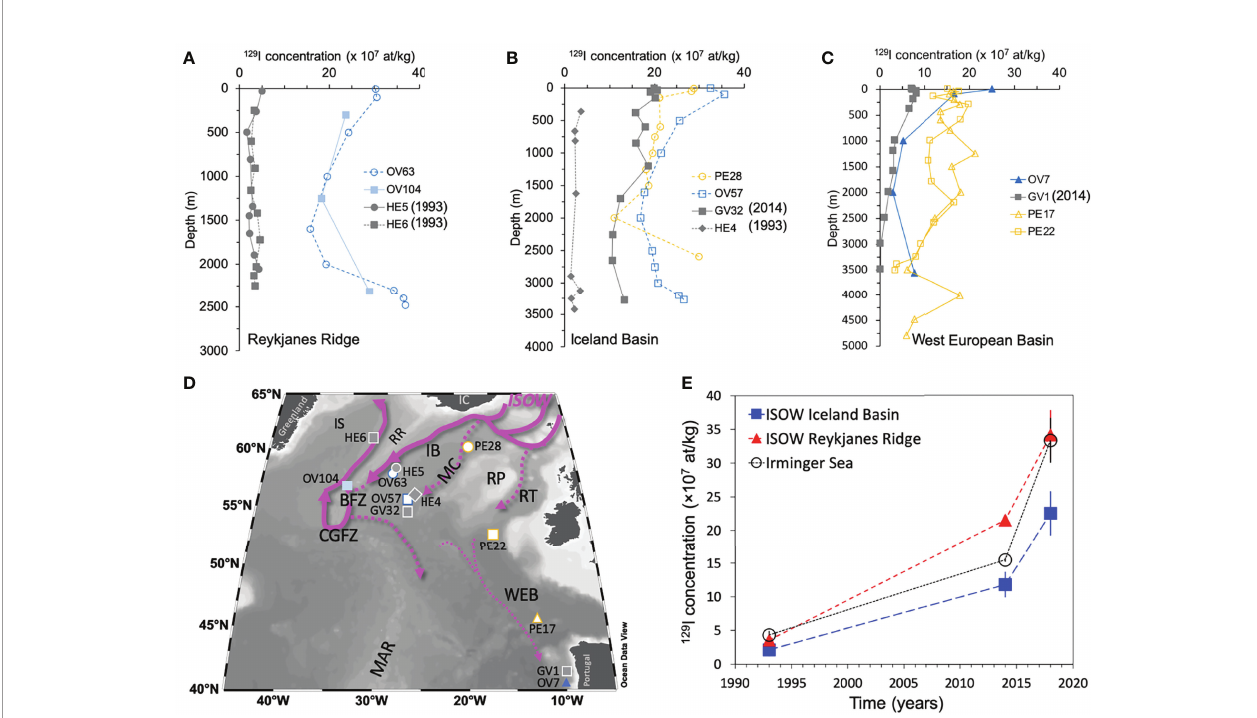
FIGURE 4 | 129 I in the Northeastern Atlantic Ocean. Depth pro fi les of 129 I obtained during OVIDE cruise in 2018 (OV, blue) and the PE424 cruise in 2017 (PE, yellow) at (A) Reykjanes Ridge, (B) the Iceland Basin, and (C) the West European Basin, are represented and compared to nearby depth pro fi les available in the literature (grey pro fi les): HE sites measured in 1993 by Edmonds et al. (2001) and GV sites from the GEOVIDE cruise in 2014 (Castrillejo et al., 2018) revisited during OVIDE in 2018. (D) Map showing the stations (*) and boundary (solid lines) and interior pathways of ISOW (dotted lines). *Stations GV1 and GV32 were at the same location as OV7 and OV57 respectively. (E) Temporal evolution of mean 129 I concentrations in ISOW at the Reykjanes Ridge, Iceland Basin and the Irminger Sea. Data used for (E) are summarized in Table S2 . Acronyms in fi gure: Bight Fracture Zone, (BFZ); Charlie – Gibbs Fracture Zone, (CGFZ); Iceland Basin, (IB); Iceland, (IC); Iceland Scotland Over fl ow Water, (ISOW); Irminger Sea, (IS); Maury Channel, (MC); Mid Atlantic Ridge, (MAR); Reykjanes Ridge, (RR); Rockall Plateau, (RP); Rockall Through, (RT); and West European Basin,